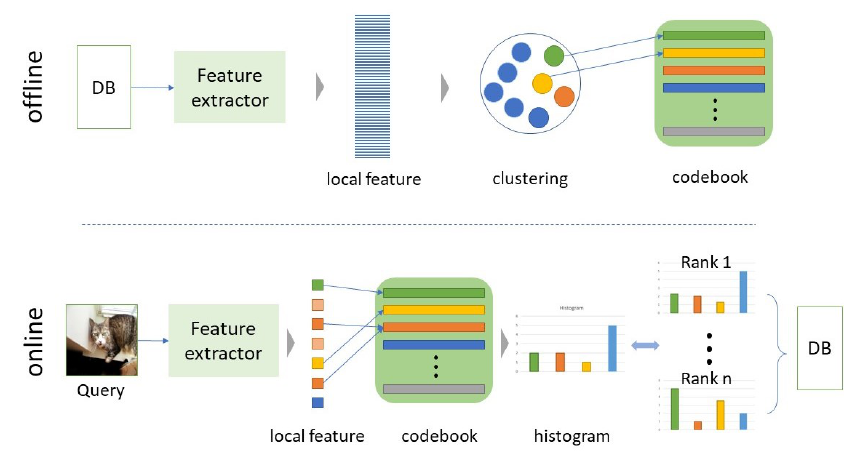
Figure 2. The pipeline of BoVW for image